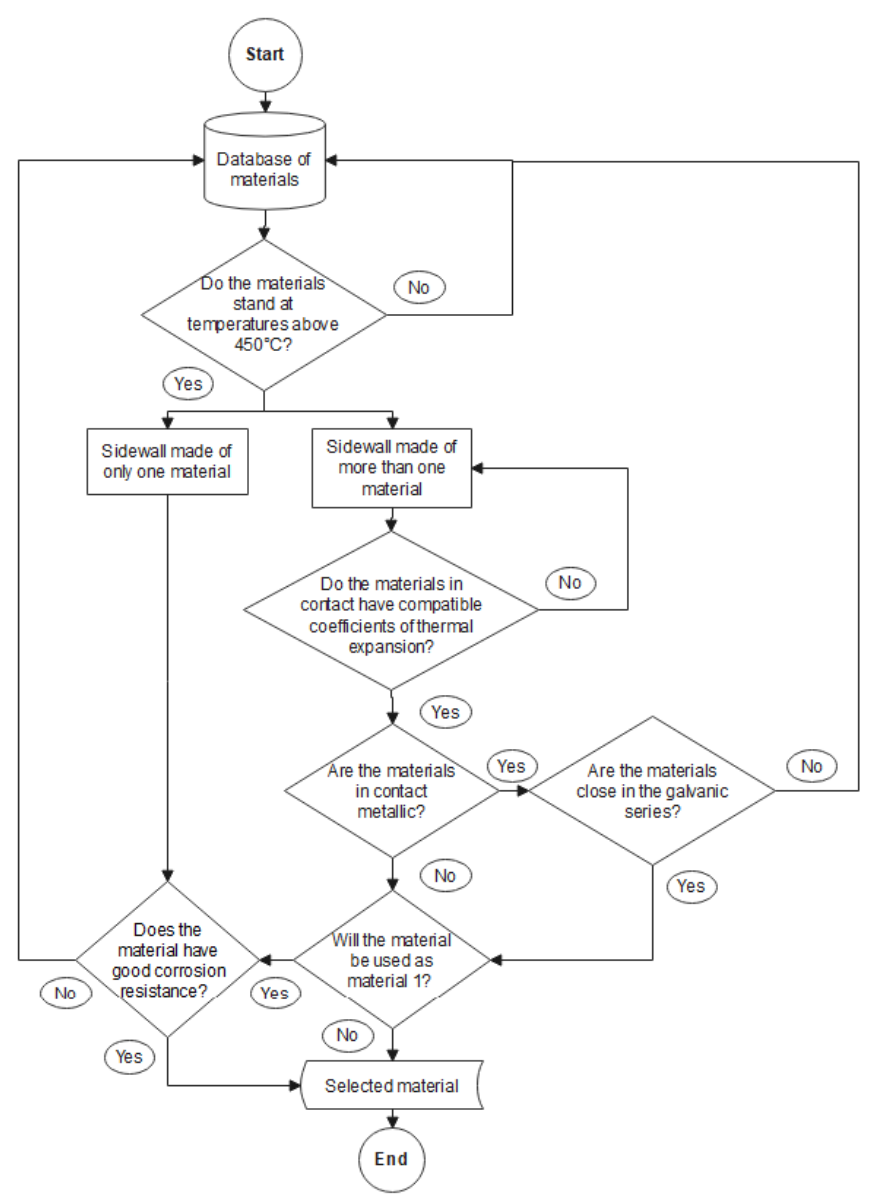
Figure 3. Flowchart used for the material selection of sidewalls.